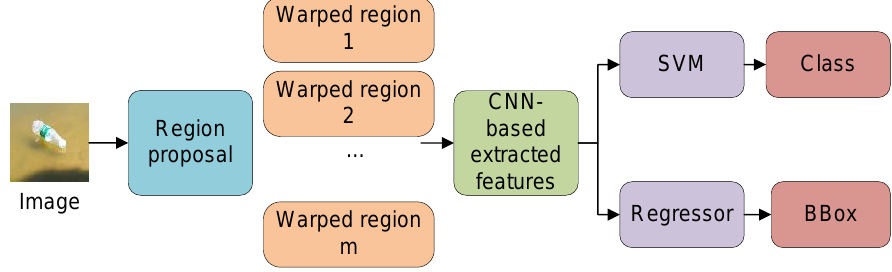
Figure 5. The R-CNN model.